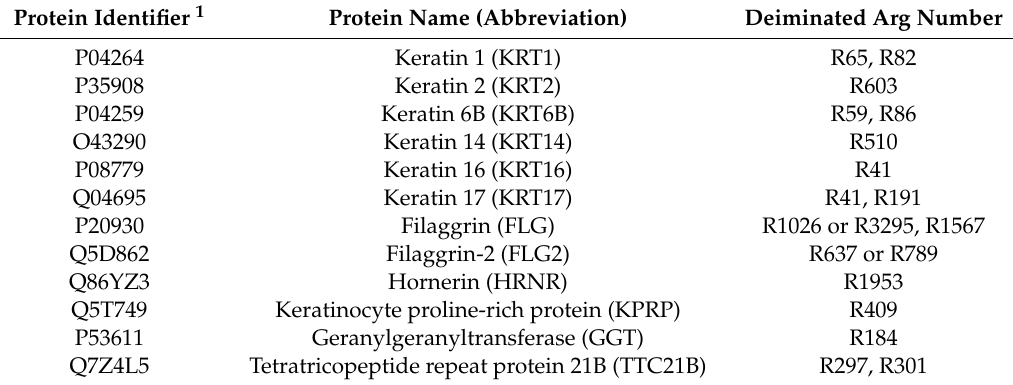
Table 1. Deiminated proteins identified by mass-spectrometry analysis of purified human plantar cornified